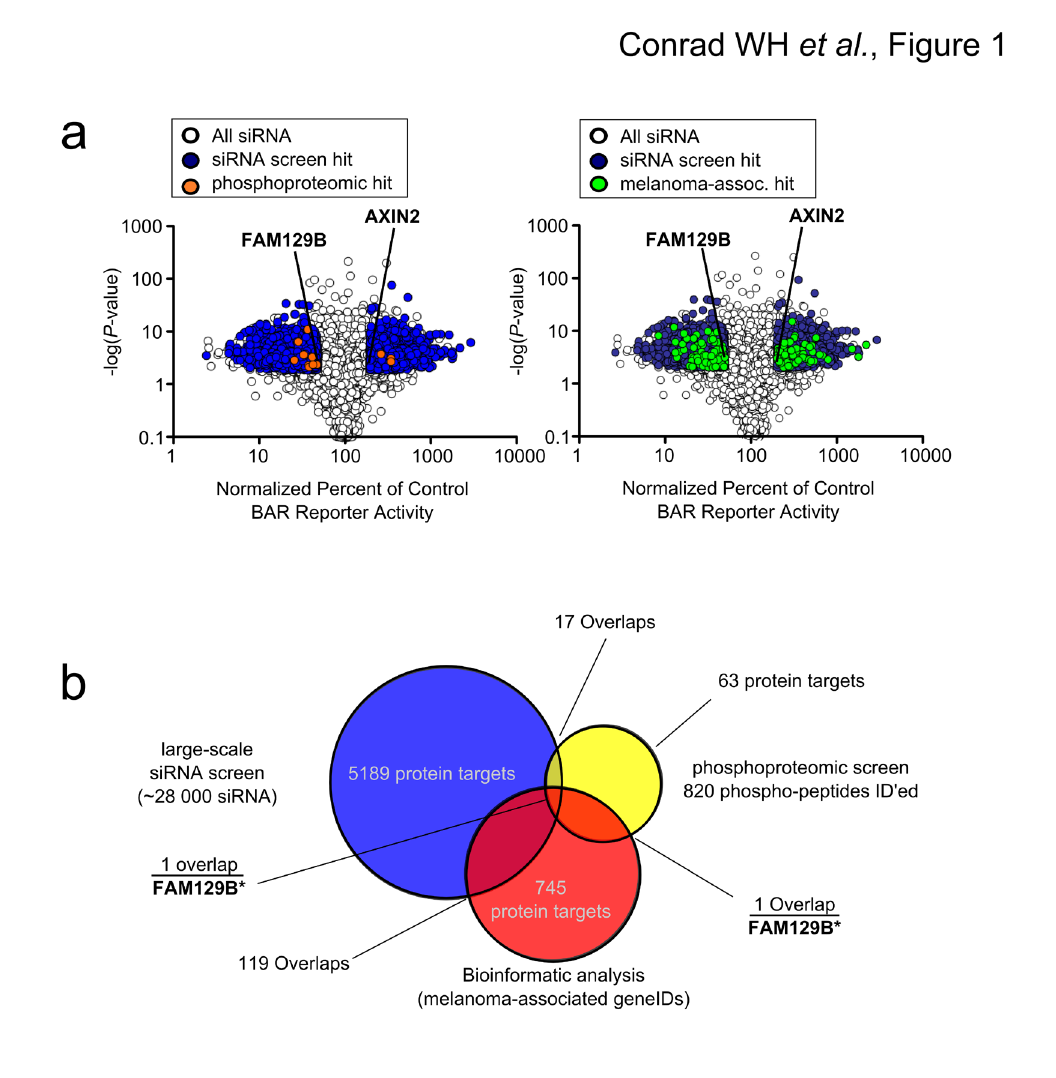
Figure 1. FAM129B is identified as a putative regulator of Wnt/ β -catenin signaling using large-scale siRNA screen integrated with phosphoproteomic and bioinformatic analyses. ( a ) Volcano plots depicting siRNA screen hits overlaid with phosphoproteomic data or bioinformatic data (left panel). Median effect of each siRNA treatment as a percent of control siRNAs were plotted against the p-value of that treatment. If, for a given gene, all siRNAs targeting that gene showed a twofold change in normalized reporter activity and a p-value <0.01, that gene was classified as a hit. This screen identified 5,189 gene products as hits, which are depicted in blue. Overlapping phosphoproteomic data from Old WM et al . (2009) 7 are depicted in orange. The known regulator of Wnt/ β -catenin signaling, AXIN2 , is indicated, as is FAM129B (right panel). Data plot is the same as the left panel with melanoma-associated genes plotted in green instead. ( b ) Venn diagram depicting overlaps between phosphoproteomic dataset, siRNA screen and melanoma-associated genes. 17 protein targets overlap between the phosphoproteomic hits and the siRNA screen, 1 protein target overlaps between the phosphoproteomic hits and melanoma-associated protein targets, and 119 proteins overlap between the siRNA screen hits and melanoma associated protein targets. Only FAM129B overlaps with all three